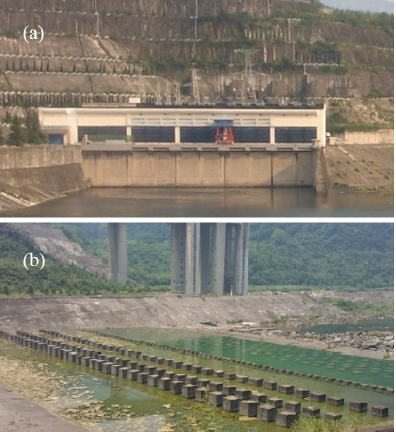
Figure 4. Linear structural targets in the dam area: (a) power plant; (b) stilling pool in water retaining wall.